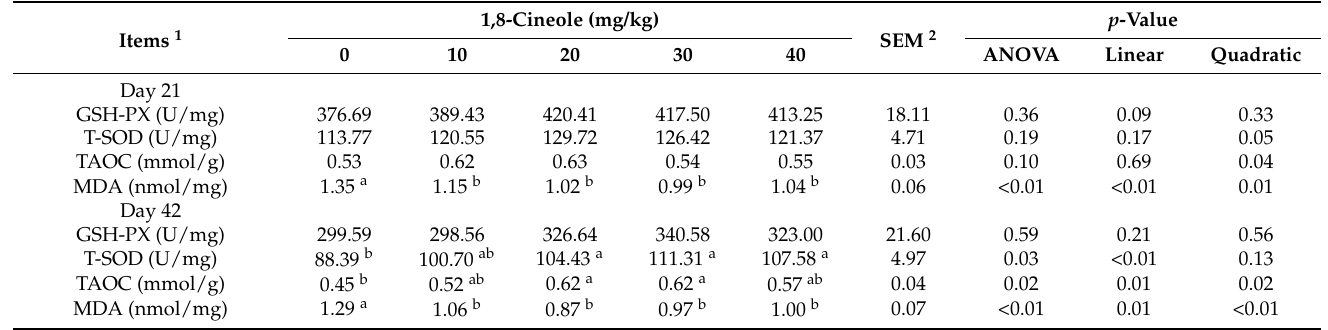
Table 4. Effects of dietary 1,8-cineole supplementation on antioxidant capacity of broiler chickens in the